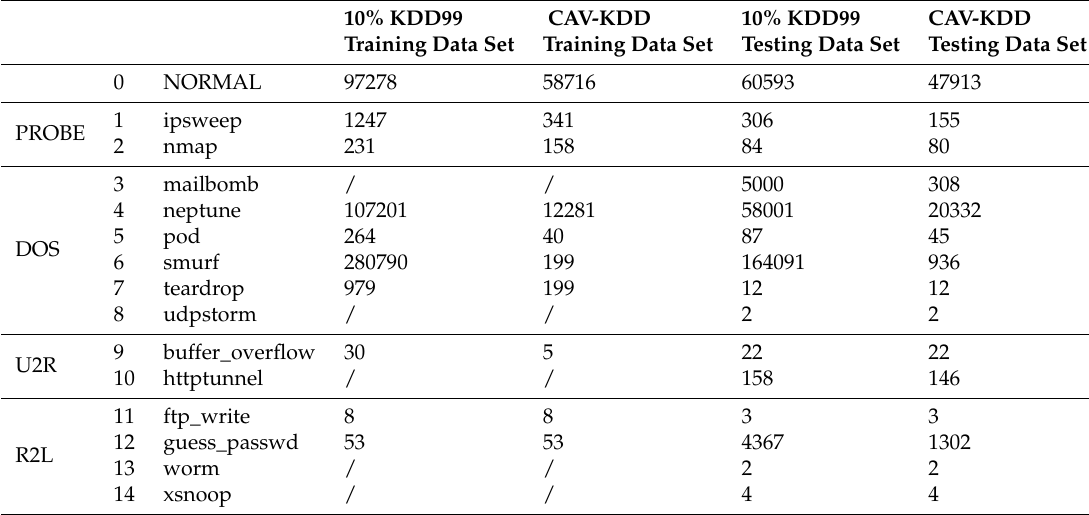
Table 6. Amount of sub-attacks types in KDD99 and